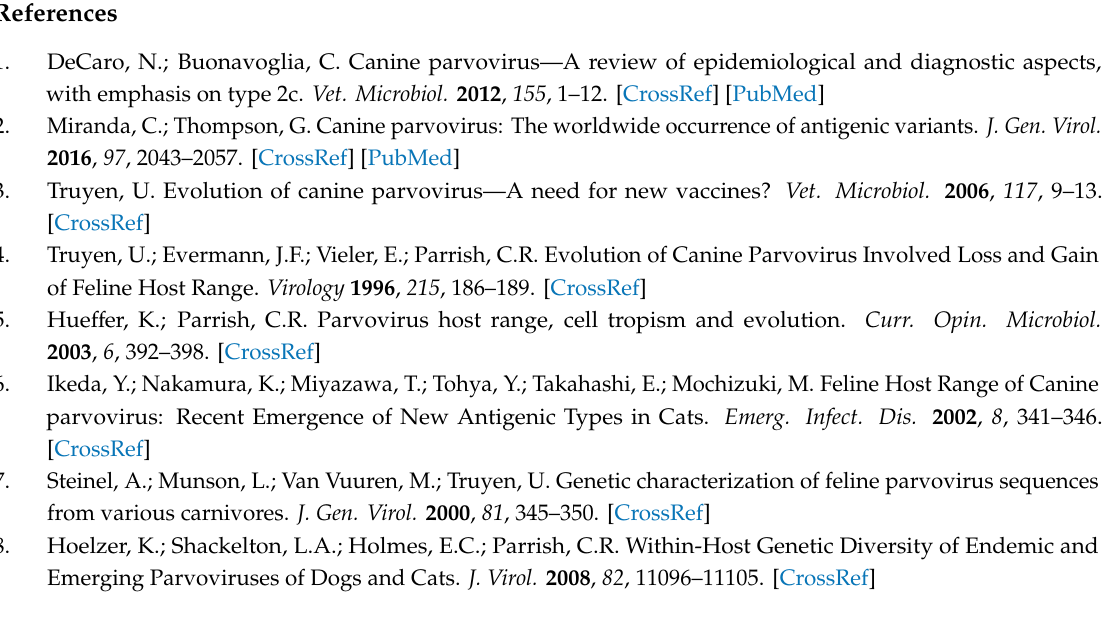
Table S1: Detailed information of the tests results, geographical location and the age of the tested samples for canine